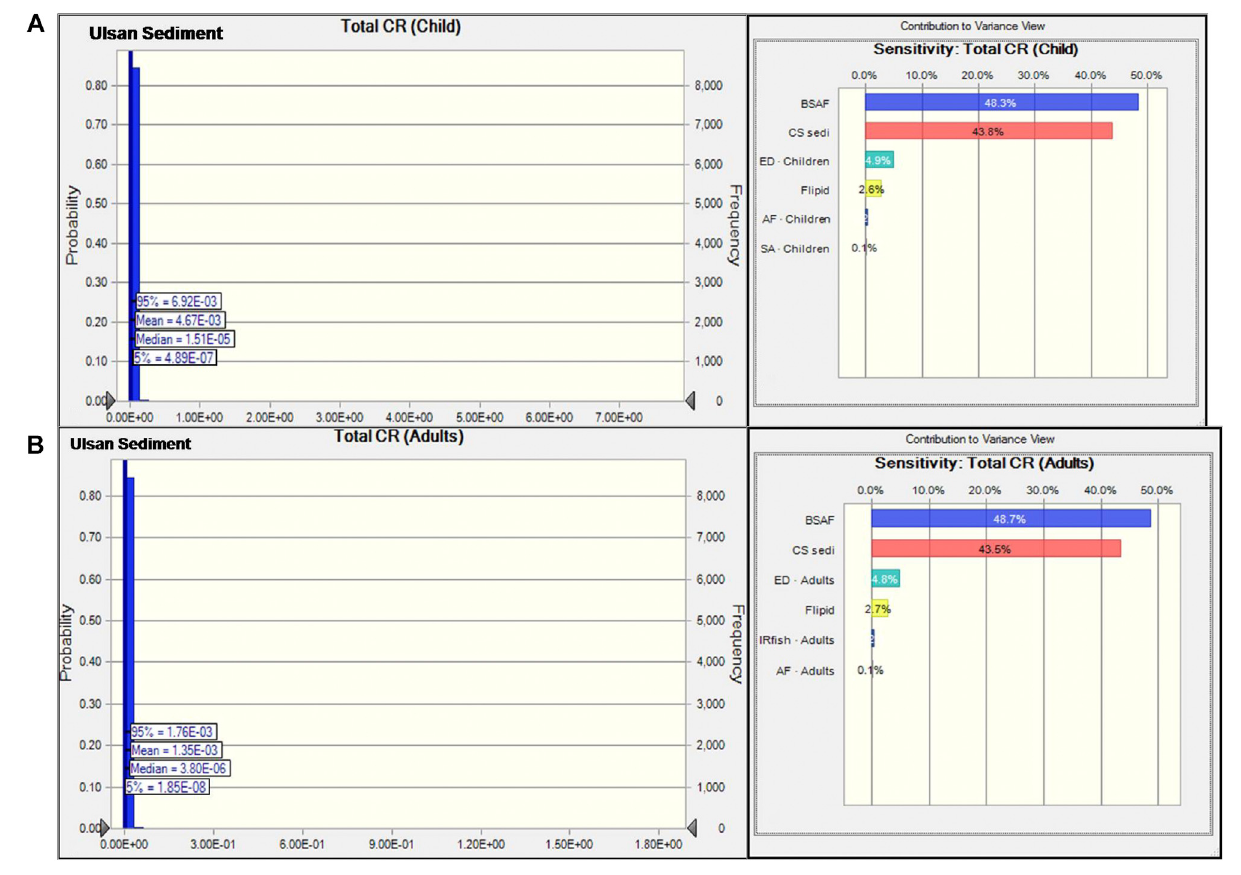
Frontiers in Environmental Science |